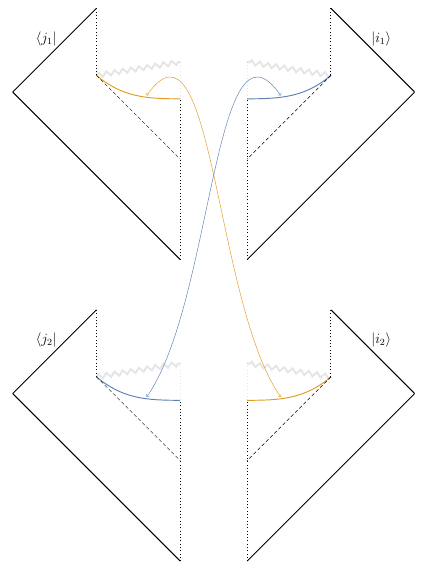
(a) Extending figure 9 as in figure 10 gives a Hawking wormhole. Two copies of this worm- hole are shown.